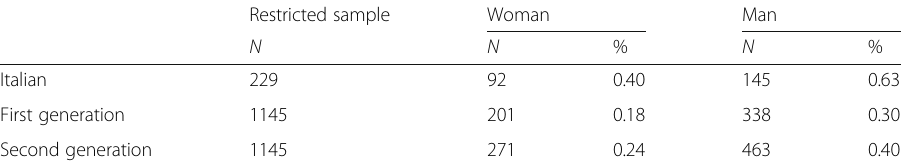
Table 3 Callback rates by ethnicity and gender Restricted